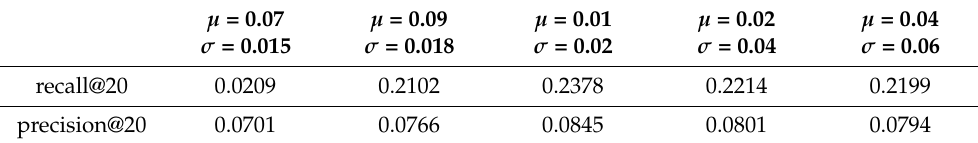
Table 4. Gaussian matrix optimal hyper-parameters.